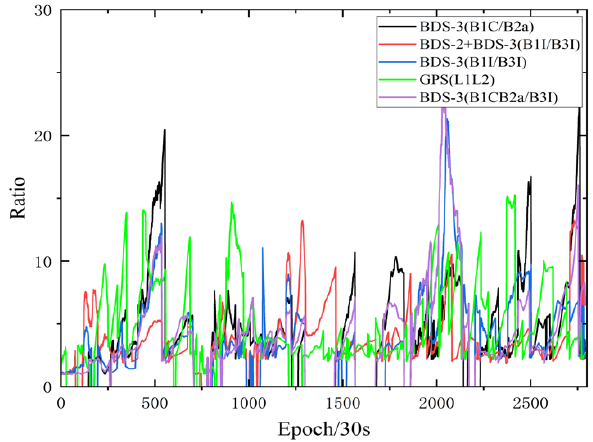
Figure 11. Ratio value variation of TGCU-TGD2 (128 km).